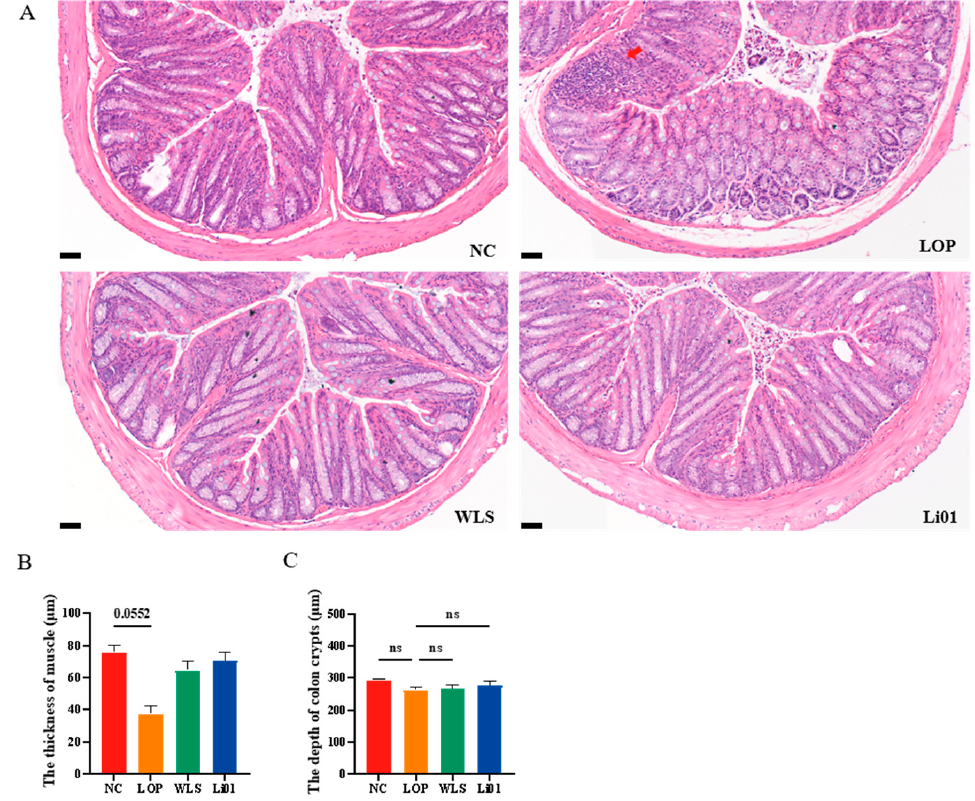
Figure 3. Histologic examination of colon sections in mice with loperamide-induced constipation (LOP) after treatment with Ligilactobacillus salivarius Li01 (Li01), Weileshu probiotic (WLS), and the control group (NC). ( A ) The red arrows indicate the inflammatory cells. The scale bars represent 50 µ m. ( B ) The thickness of muscle. ( C ) The depth of colon crypts. Data are presented as mean ± SEM, n = 3. Significant differences are denoted by “ns” ( p ≥ 0.05).